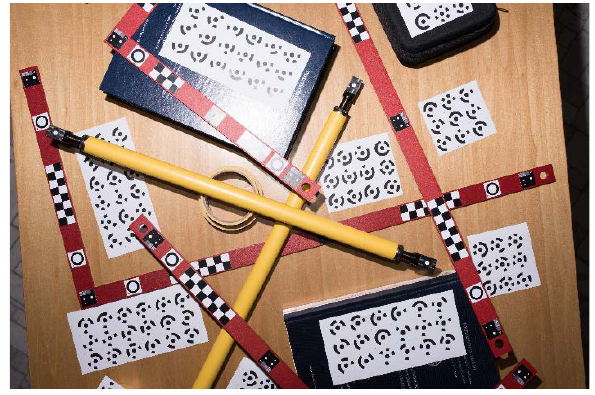
Figure 12. Two details of the photogrammetric